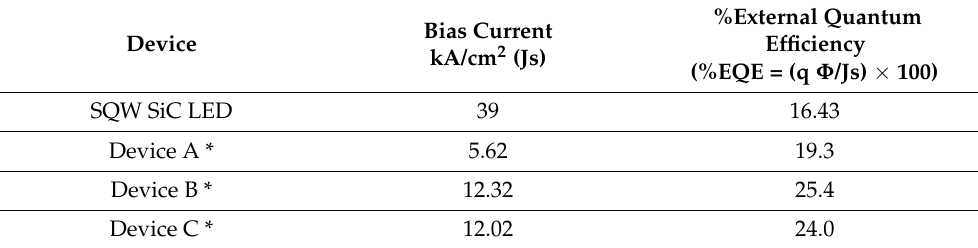
Table 5. Comparison of the external quantum efficiencies of simulated. SiC LED with literature [50].